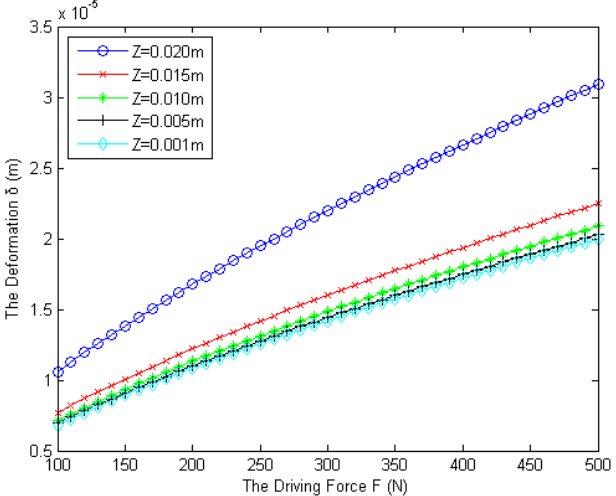
Figure 6. The relationship between the driving force and the maximum deformation under different depths of propulsion. In this, to make the graph easier to read, trend lines have been added.